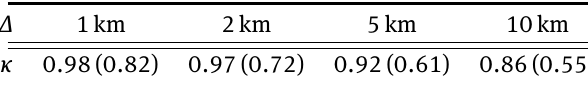
Table 4: The averages (and minimums) of κ of Eq. (35) for the south of mainland Norway are given below.